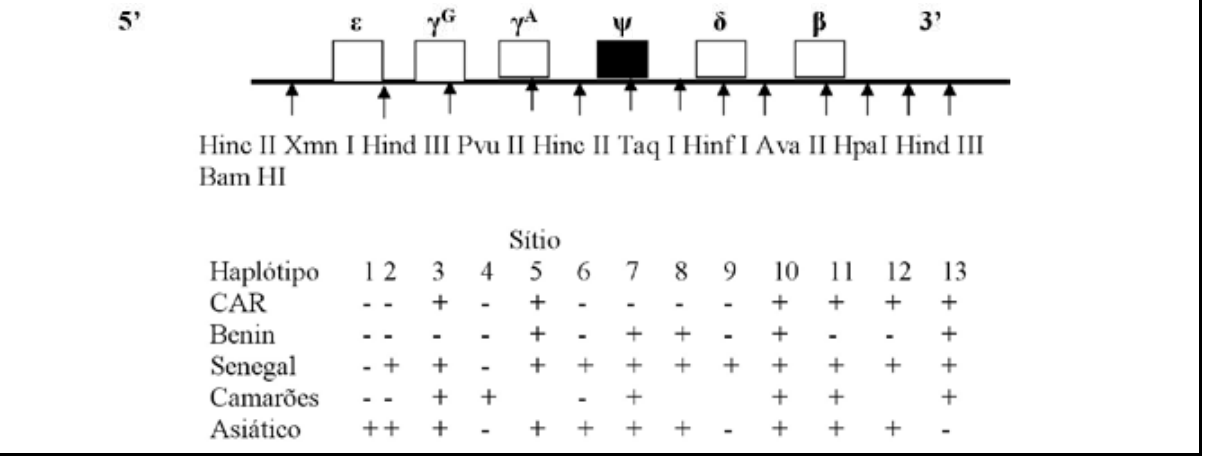
Figura 2 – Principais haplotipos do complexo do gene ß s definido pela ação de 13 enzimas de